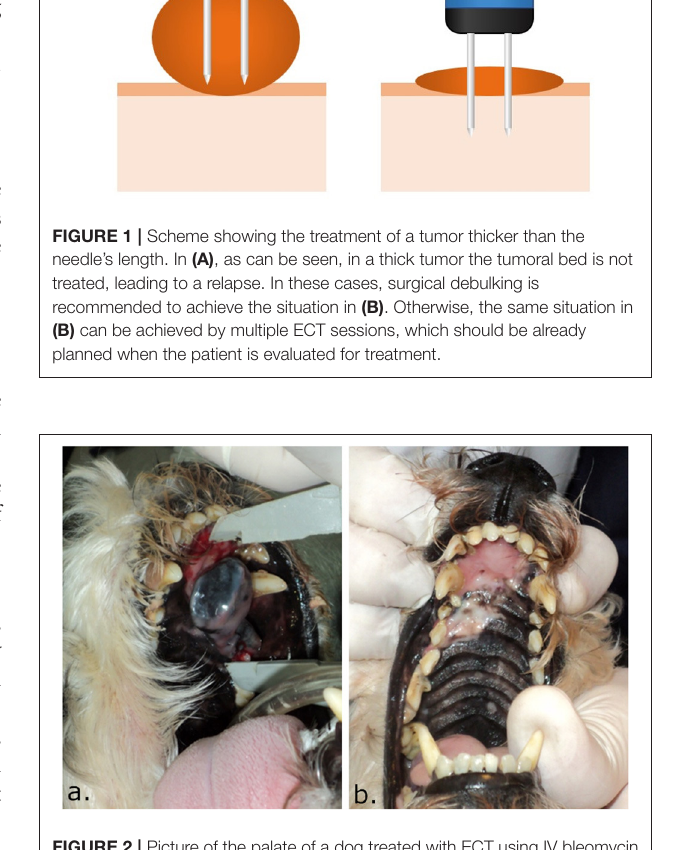
FIGURE 2 | Picture of the palate of a dog treated with ECT using IV bleomycin where induced hypopigmentation can be seen. In (a) , the dog with a melanoma in the palate before the treatment. In (b) , 4 months after ECT, a complete response was obtained and a hypopigmented area is seen where the tumor was located. Note that as the bone was not compromised, the palate integrity was preserved. In some cases, hypopigmentation may partially revert with